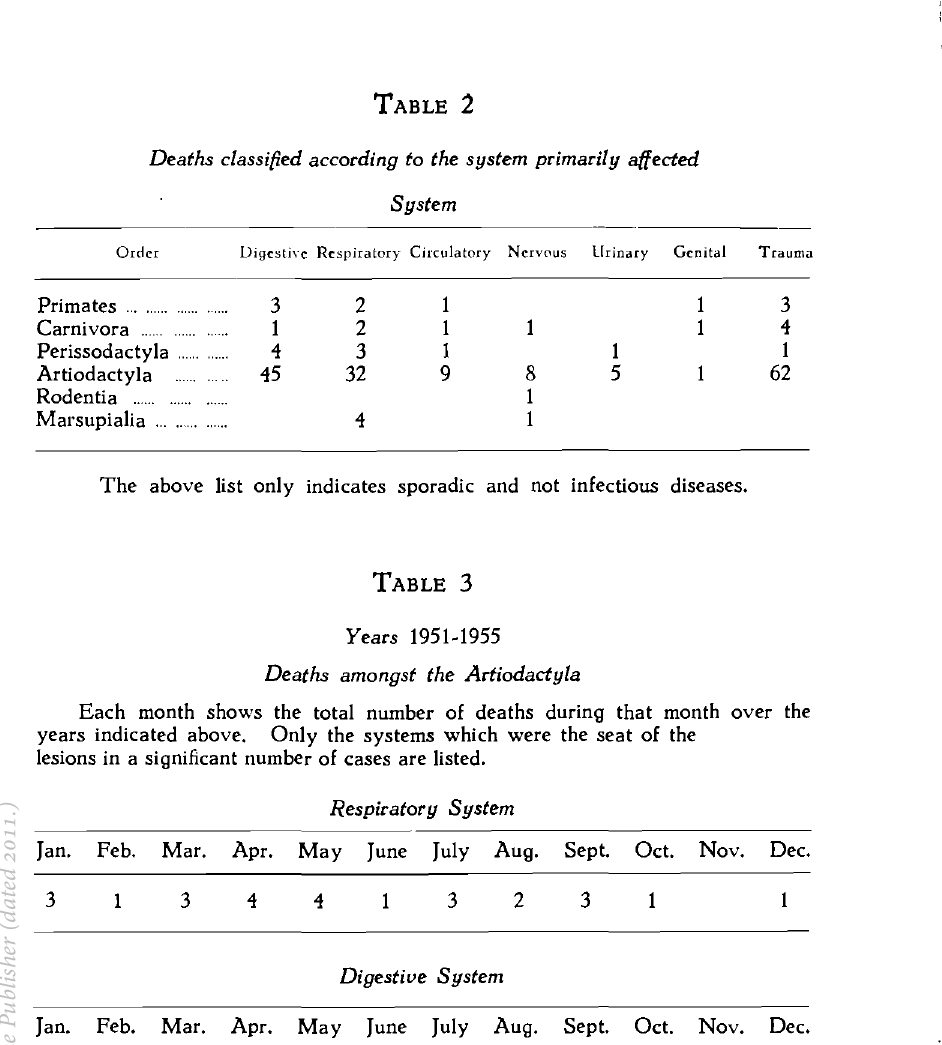
Years 1951-1955 Mortality amongst all species (first column) and Artiodactyla (second column).